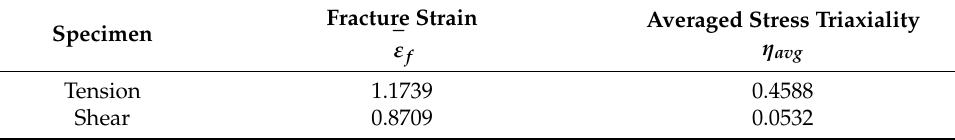
Table 2. Calibrated fracture